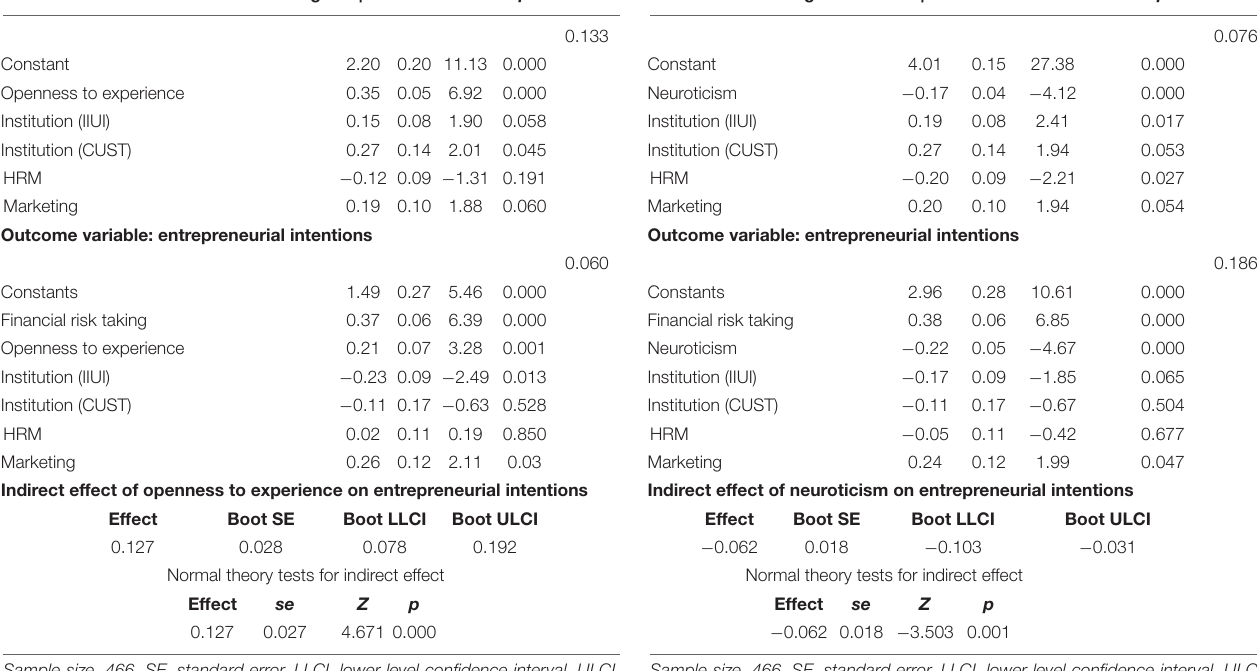
TABLE 4 | Mediating role of financial risk taking between openness to experience and entrepreneurial intentions. Outcome variable: financial risk taking